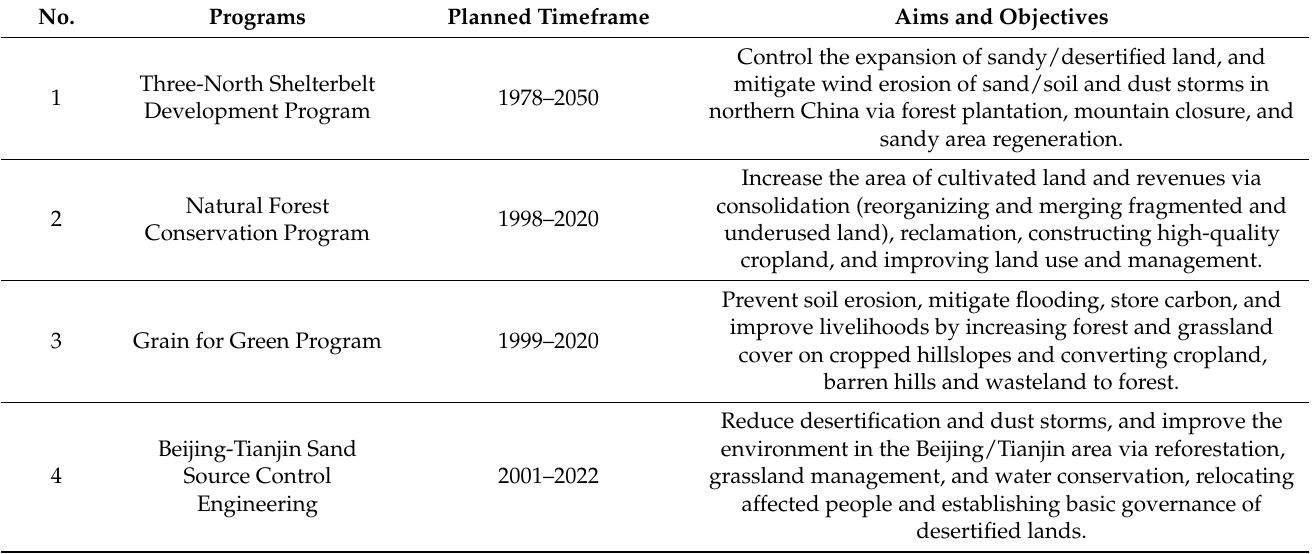
Table A7. Summary of the land policy implemented in the Yellow River